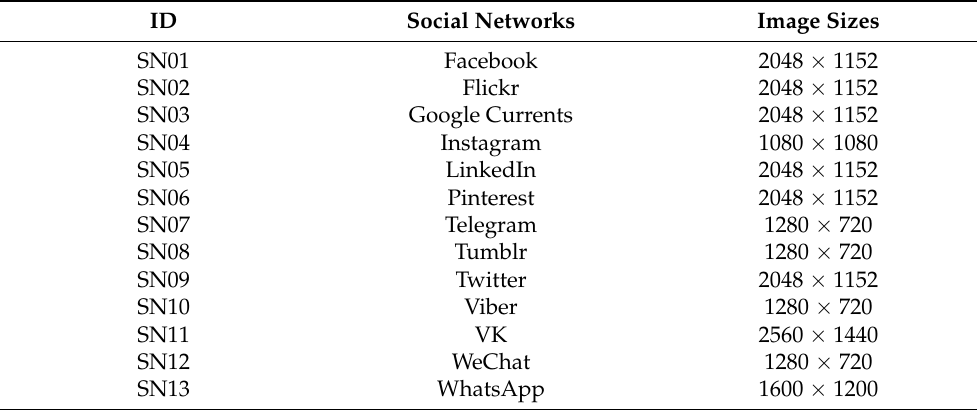
Table 1. Social Networks used for investigation activities and the default pixel resolution accepted by each